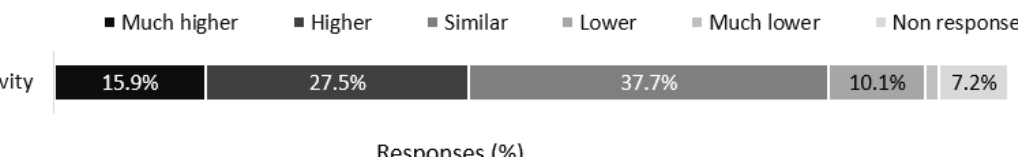
Figure 8. Perception on receptivity to the label shown by customers in the regions affected by the storm compared to customers in other regions; N = 69.